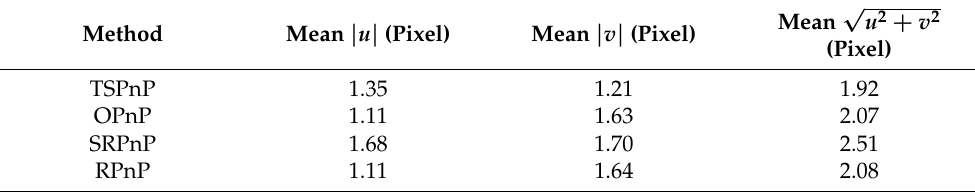
Table 3. Reprojection error compared to other calibration